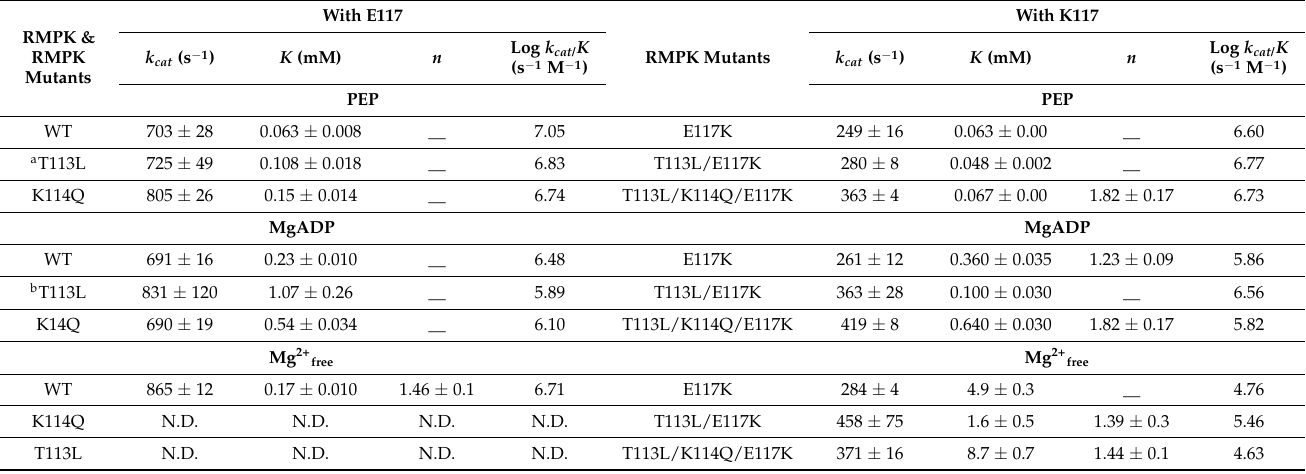
Table 2. Kinetic constants for PEP 3 − , MgADP complex and Mg 2+ free of WT-RMPK, K114Q-RMPK, E117K-RMPK, T113L/E117K-RMPK and T113L/K114Q/E117K-RMPK. The experiments for PEP 3